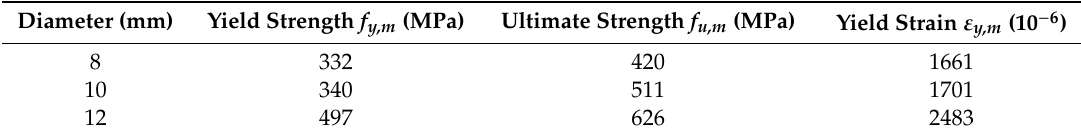
Table 1. Mechanical properties of